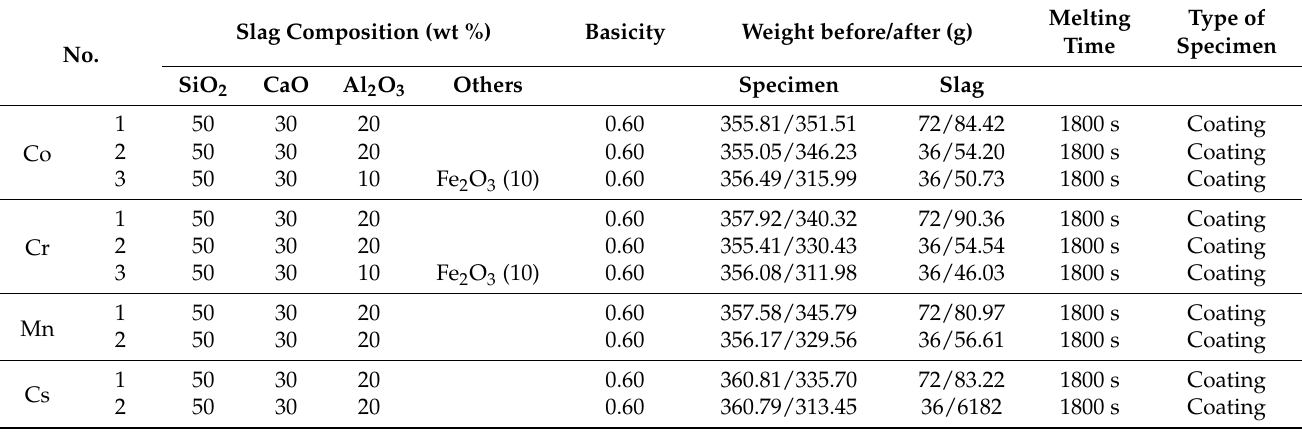
Table 7. Experimental conditions and weight change for S41C.